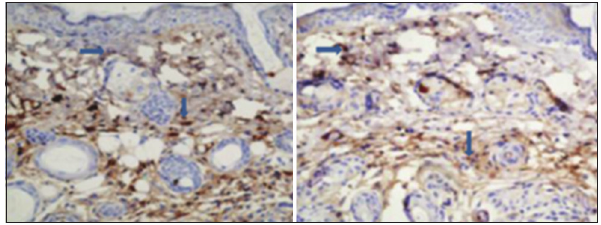
Figure-2: Immunohistochemistry image showing the extent of iNOS expression in skin of diabetic rats (left) and control rats (right). Arrow points at brown color indicate iNOS (40×). There was a significant difference in the expression of iNOS in the skin of control rats when compared to that in alloxan-induced diabetic rats. iNOS=Inducible nitric oxide synthase.